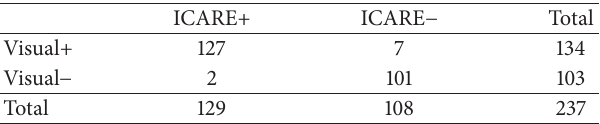
Table 4: Correlations of FI with anti-dsDNA antibody levels and IFI